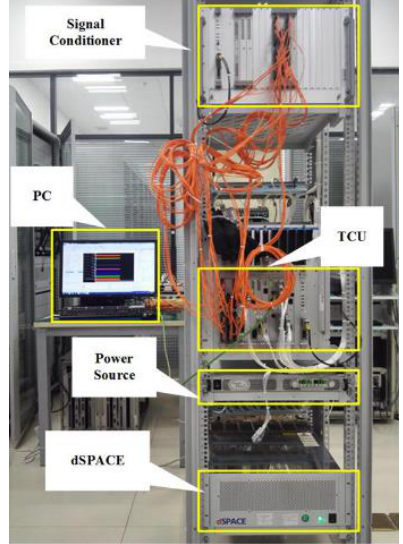
Figure 8. The HIL-based experimental platform.